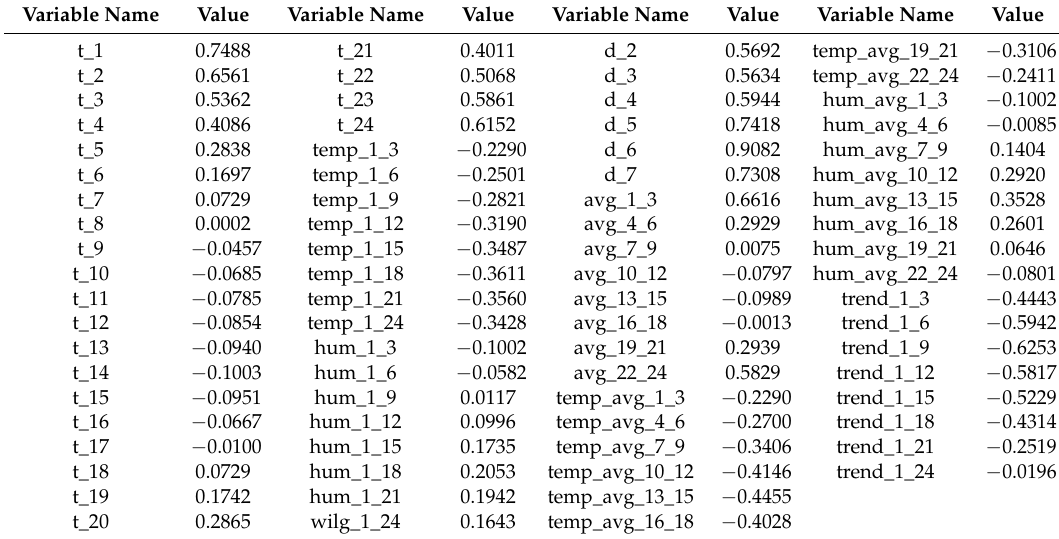
Table 5. The results of the Spearman correlation coefficient for the quantitative variables.